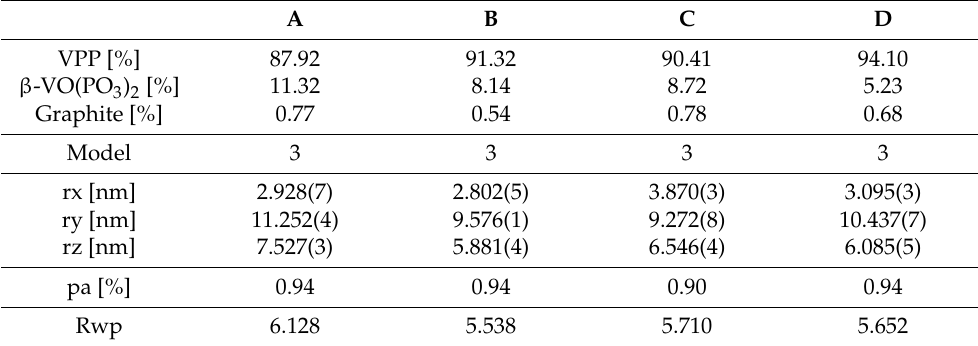
Table 4. Summary of the yielded laboratory-scale X-ray powder diffraction results after applying the developed full profile fitting strategy.